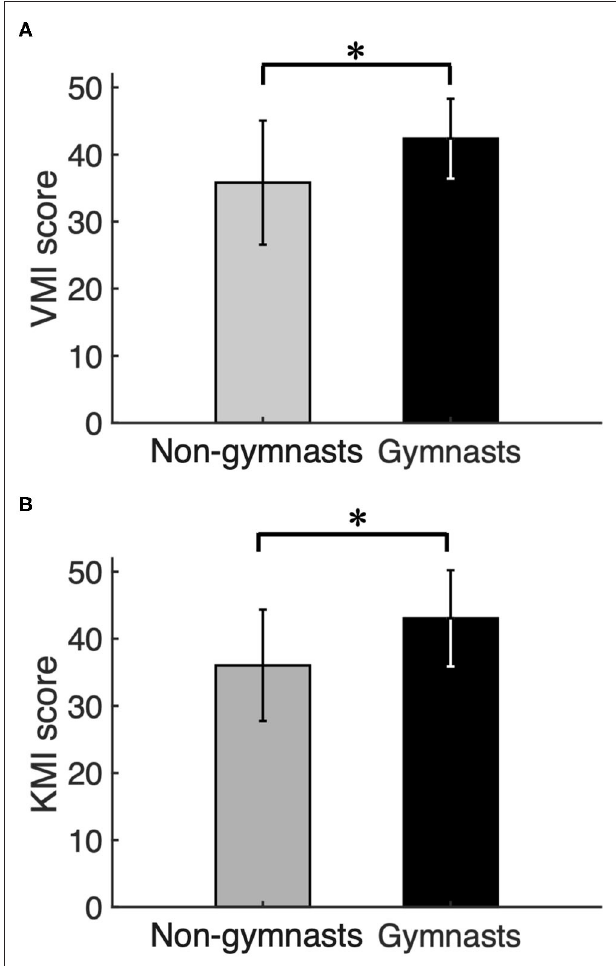
FIGURE 2 | Results of psychological experiment. Group data (mean ± S.D.) for visual motor imagery (VMI) (A) and kinesthetic motor imagery (KMI) (B) scores obtained from the Kinesthetic and Visual Imagery Questionnaire (KVIQ) are shown for both groups. The gray bars represent the data for non-gymnasts, while the black bars represents the data for gymnasts. * P <